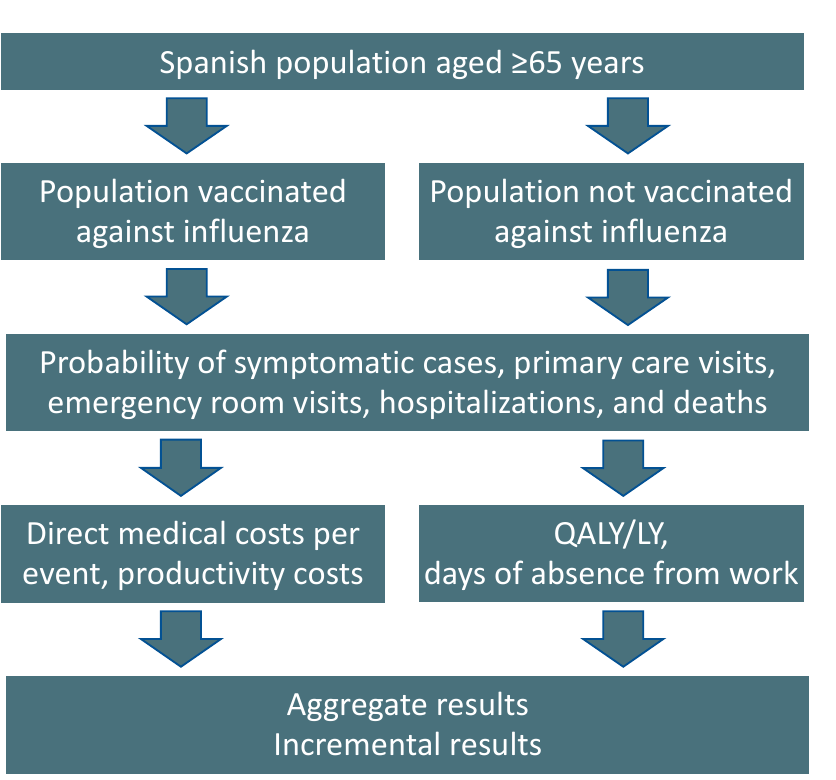
Figure 1. Schematic of the health economic model. LY, life year; QALY, quality-adjusted life year. Table 1. Incidence rates of influenza-related clinical events per 100,000 subjects aged ≥ 65 years.